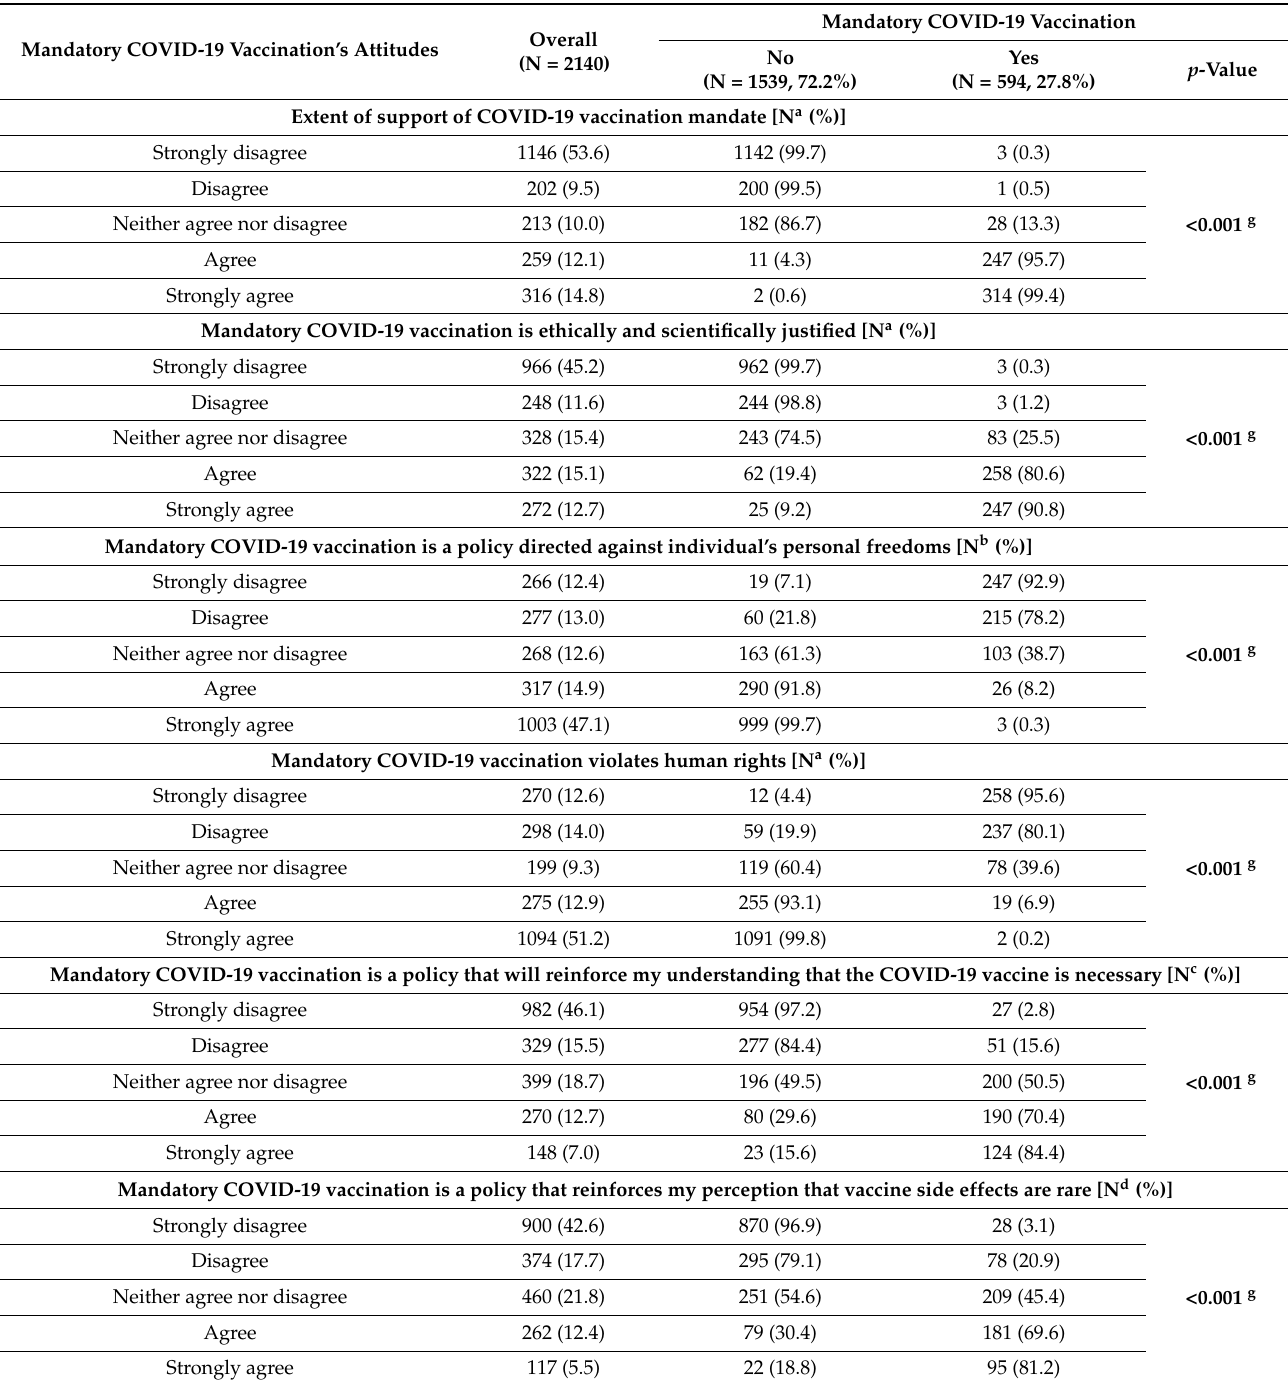
Table 3. Participants’ attitudes towards mandatory COVID-19 vaccination, overall and by mandatory vaccination